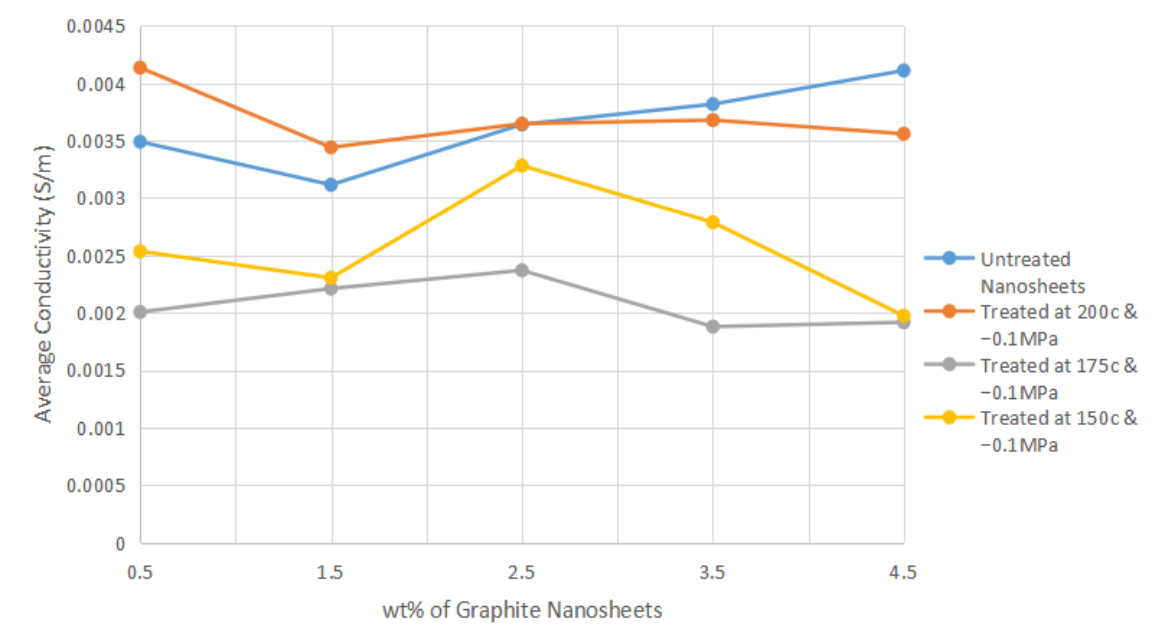
Figure 3. Average Conductivity of All the Nylon 610/Graphite Nanosheets Nanocomposites.